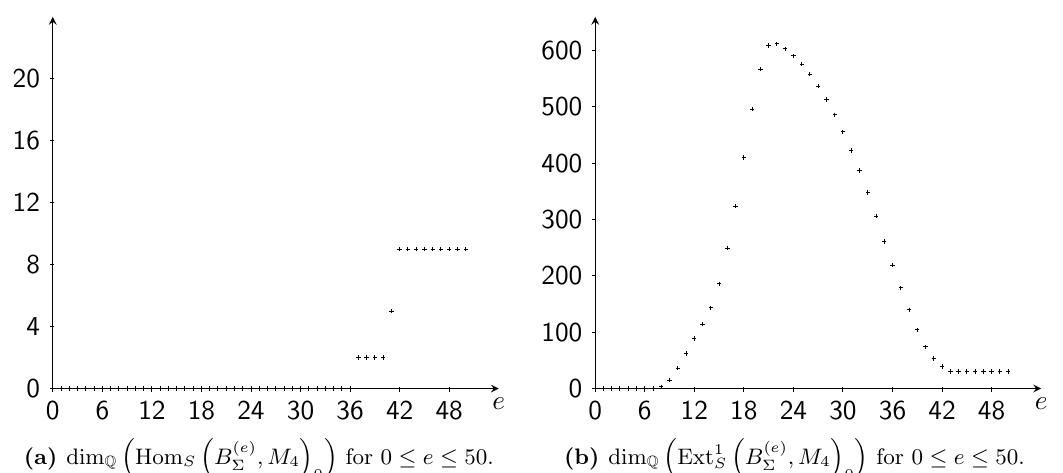
Figure 9. Computing the sheaf cohomologies of f M 4 with plesken .